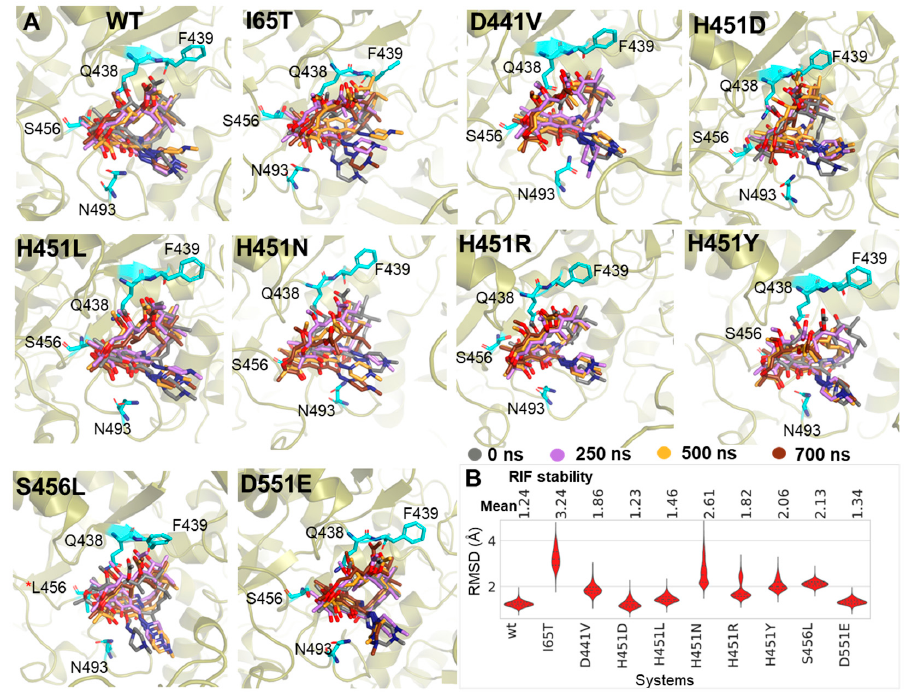
Figure 5. Mutant-induced RIF destabilization. ( A ) 3D illustration of RIF’s shift from the active pose when in the presence of the studied RIF R mutations. RIF snapshots (stick representation) were taken at 0 ns (grey), 250 ns (purple), 500 ns (orange) and 700 ns (brown), respectively. ( B ) The violin plots convey RIF’s stability (with reference to the RIF-BP) for the wt and mt s over the equilibrated timeframes. The dotted lines on the violins represent the 25th, 50th and 75th quartiles, while mean RMSD values are indicated above the